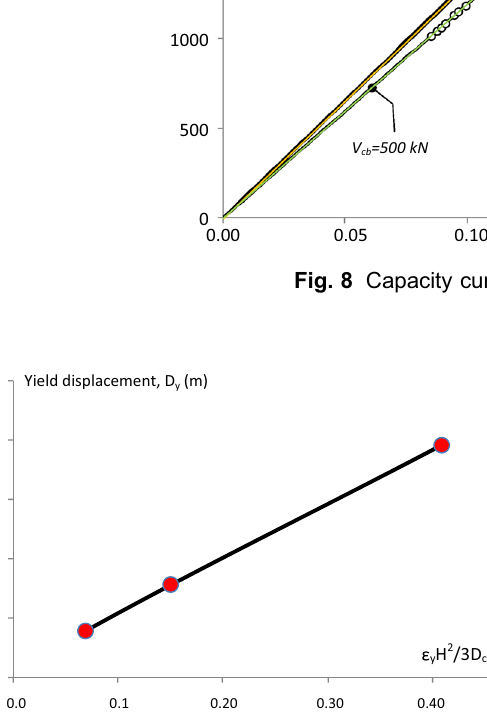
Fig. 9 Mean yield displacements of the three sets of coupled